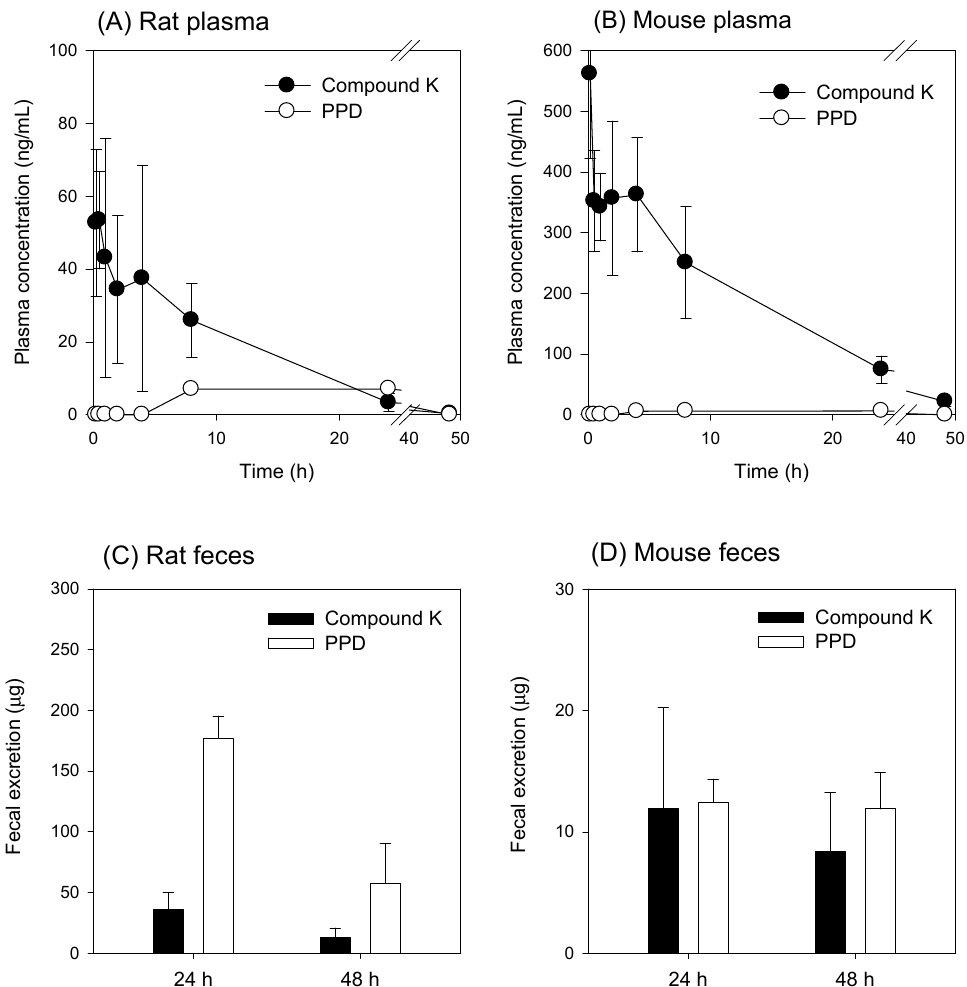
Figure 7. Plasma concentration vs. time profile of compound K and PPD (a metabolite of compound K) following intravenous injection of compound K at a single dose of 2 mg / kg in ( A ) rats and ( B ) mice. Fecal excretion of compound K and PPD following intravenous injection of compound K at a single dose of 2 mg / kg in ( C ) rats and ( D ) mice. Data expressed as mean ± standard deviation of four samples for each time point. Table 4. Recovery of compound K and PPD from urine and feces over the 48 h period following intravenous injection of compound K at a single dose of 2 mg / kg. Species